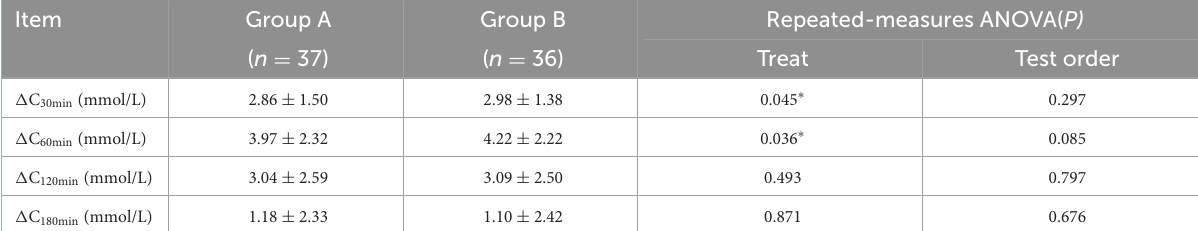
TABLE 5 Repeated ANOVA of postprandial glucose by test order. Item Group A Group B Repeated-measures ANOVA(